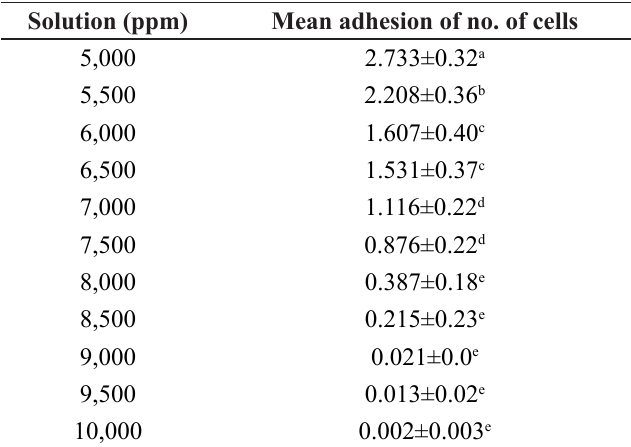
Table 2: Mean adhesions of C. albicans (standard isolate + seven laboratory isolates) against different concentrations of P. betle leaf ethanol extract Solution (ppm) Mean adhesion of no. of cells